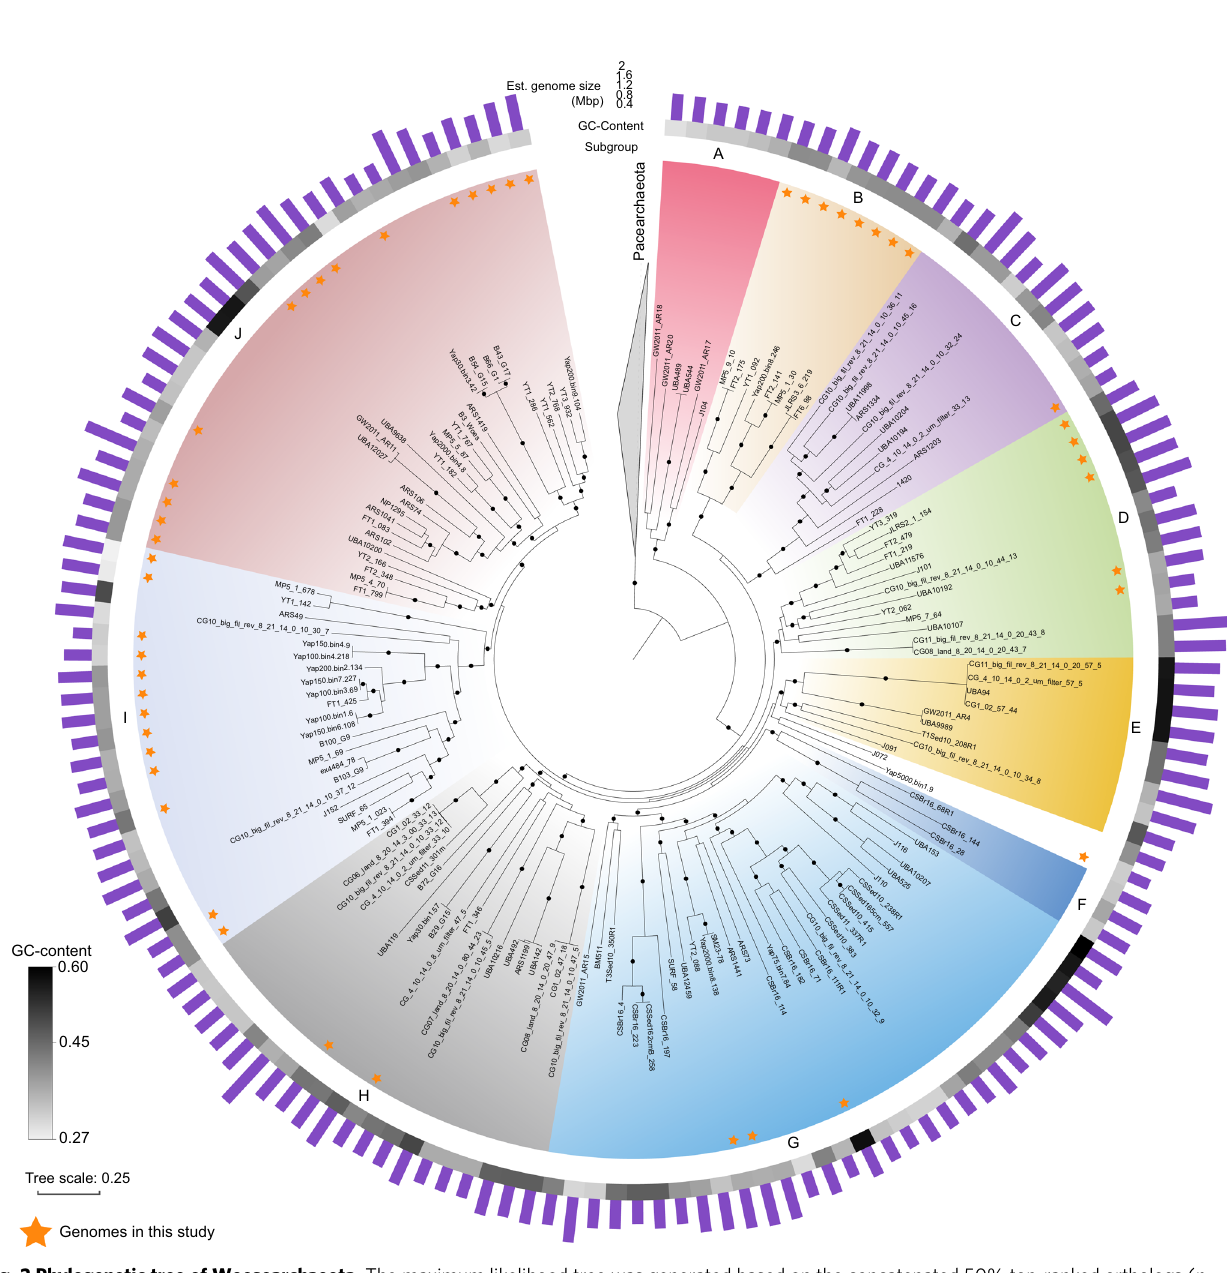
Fig. 2 Phylogenetic tree of Woesearchaeota. The maximum likelihood tree was generated based on the concatenated 50% top-ranked orthologs ( n = 38, 10,896 sites) with IQ-Tree (v2.0.7) using LG + F + R + C60 model. The tree includes 152 Woesearchaeota genomes and is rooted by 30 Pacearchaeota genomes. 49 MAGs generated in this study are marked by the star. Black dots denote nodes with UFBOOT support values ≥ 95% and SH-aLRT values ≥ 80%. Scale bar shows the average number of substitutions per site. The minimum number of orthologs in Woesearchaeota MAGs is 21. J072 and Yap5000.bin1.9 were ungrouped as they did not form well-supported clade (UFBOOT< 95% and SH-aLRT <80%). Source data are provided as a Source Data fi